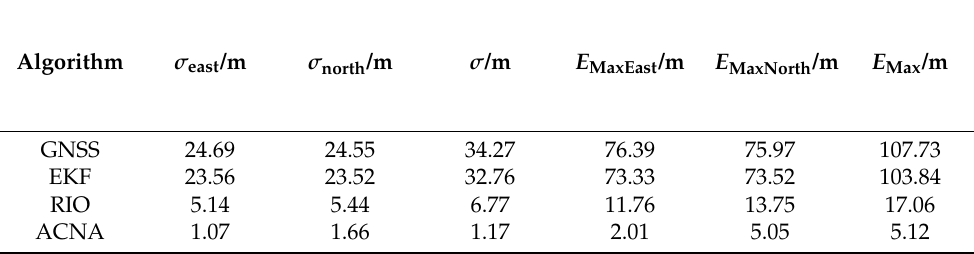
Figure 16. The trajectories of the three algorithms on data set (cid:101) Ψ 3 : ( a ) EKF; ( b ) RIO; ( c ) ACNA. Table 4. The east, north and relative positioning accuracy and maximum error of the three algorithms in the data set (cid:101) Ψ 3 .